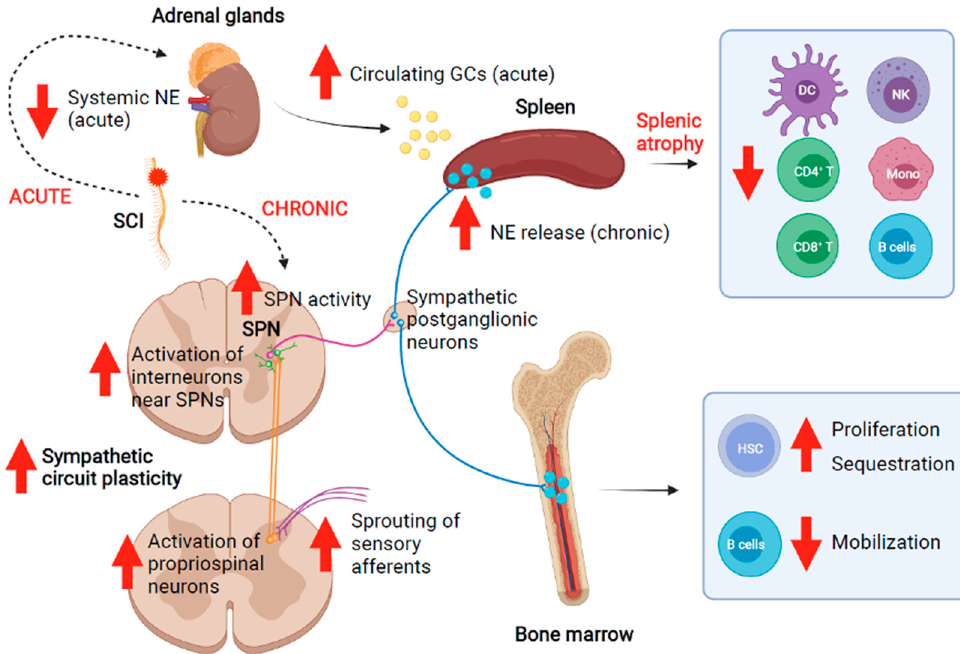
Figure 2. After a SCI, there is an acute drop in systemic norepinephrine (NE) and an increase in plasma glucocorticoids (GCs) released by the adrenal glands. Chronically, increased neural circuit plasticity results in sympathetic hyperreflexia and release of NE by sympathetic post-ganglionic neurons, including those targeting the spleen and other lymphoid organs such as the bone marrow. These changes after SCI result in measurable altered immune profile and function. Created using BioRender.com accessed on 2 September 2021.